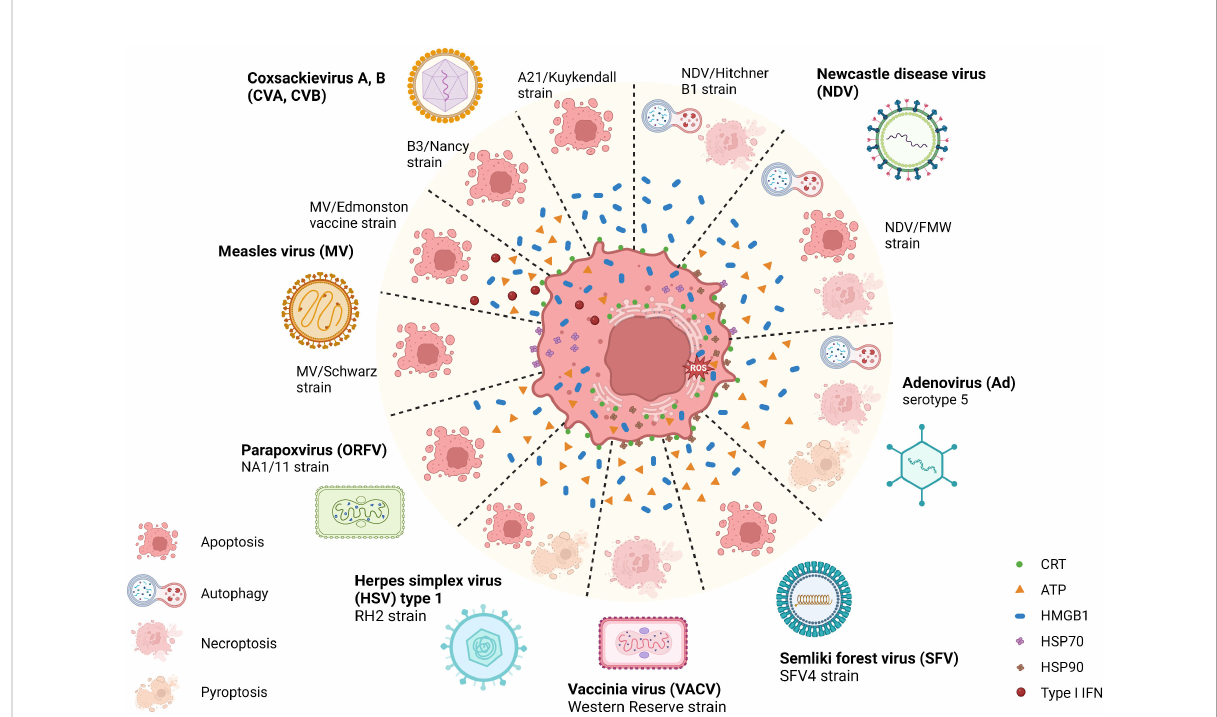
FIGURE 2 Illustration of the immunogenic cell death related pathways induced by natural OVs. Several natural oncolytic viruses (OVs), including coxsackievirus A, B (CVA, CVB), Newcastle disease virus (NDV), adenovirus (Ad), semliki forest virus (SFV), measles virus (MV), herpes simplex virus (HSV) and poxviruses, such as vaccinia virus (VACV) and parapoxvirus (ORFV) can induce a distinct mode of immunogenic cell death (ICD). For example, CVA, CVB, MV, ORFV, and SFV induce immunogenic apoptosis, and VACV induces necroptosis. While some OVs, such as HSV, NDV, and Ad, induce multimodal cell death, mediating chronic exposure of DAMPs in dying cancer cells. During this phase, the dying tumor cells exposing multiple damage-associated molecular patterns (DAMPs) recruit innate immune responders, thus connecting the bridge between TME and host innate immune machinery, eliciting a potent antitumor immune response. Created with